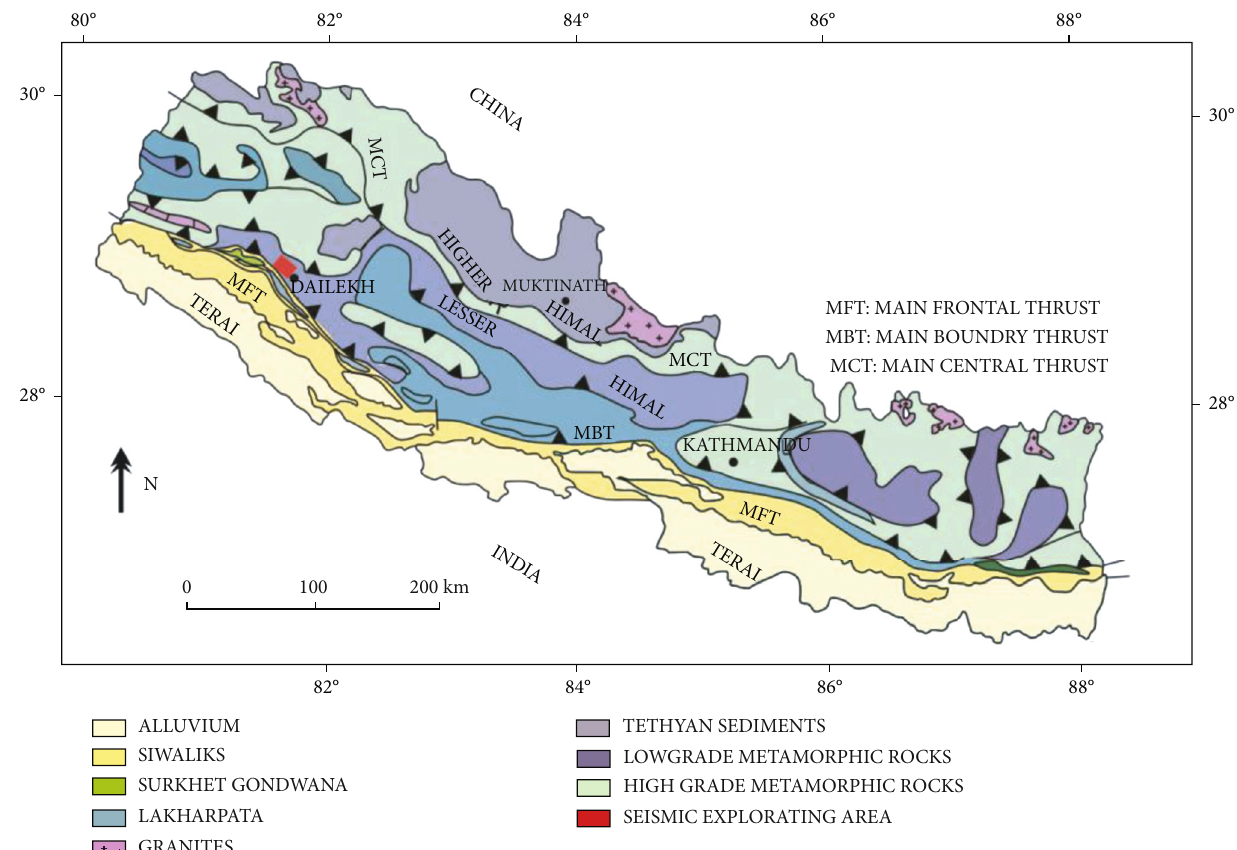
Figure 1: The simpli fi ed geological map of Nepal (by [9]; red box is working area in